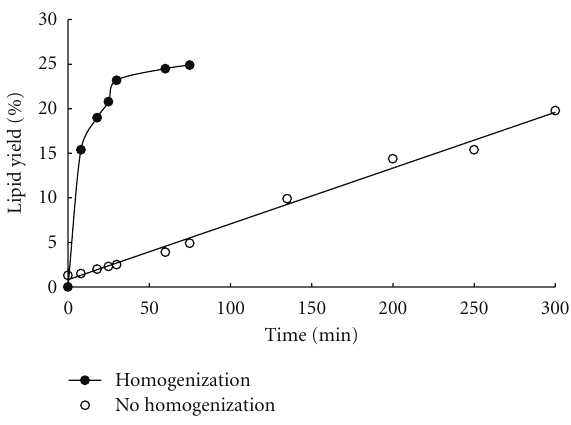
Figure 4: Comparison of the lipid extraction profile with ( • ) and without ( (cid:4) ) homogenization as a pretreatment extracted with chloroform:methanol (2 :1, v/v) solvent. Extraction yield was calculated by the weight ratio of the extracted lipids to the total dried biomass.